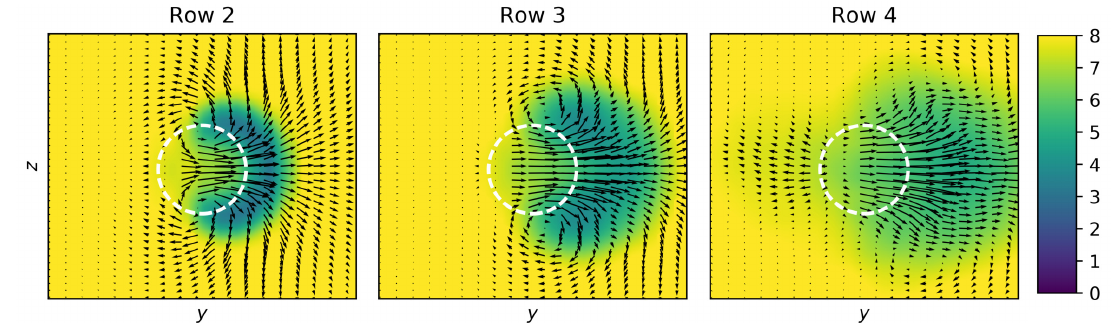
Figure 8. Time-averaged cross-sectional views of streamwise velocity (cid:101) u x for case Y at a distance D /2 upstream of the downstream turbines in column C4. Arrows represent the projection of the velocity vector on the cross-sectional plane. Dashed white lines indicate turbine rotor locations. Coloring in m s − 1